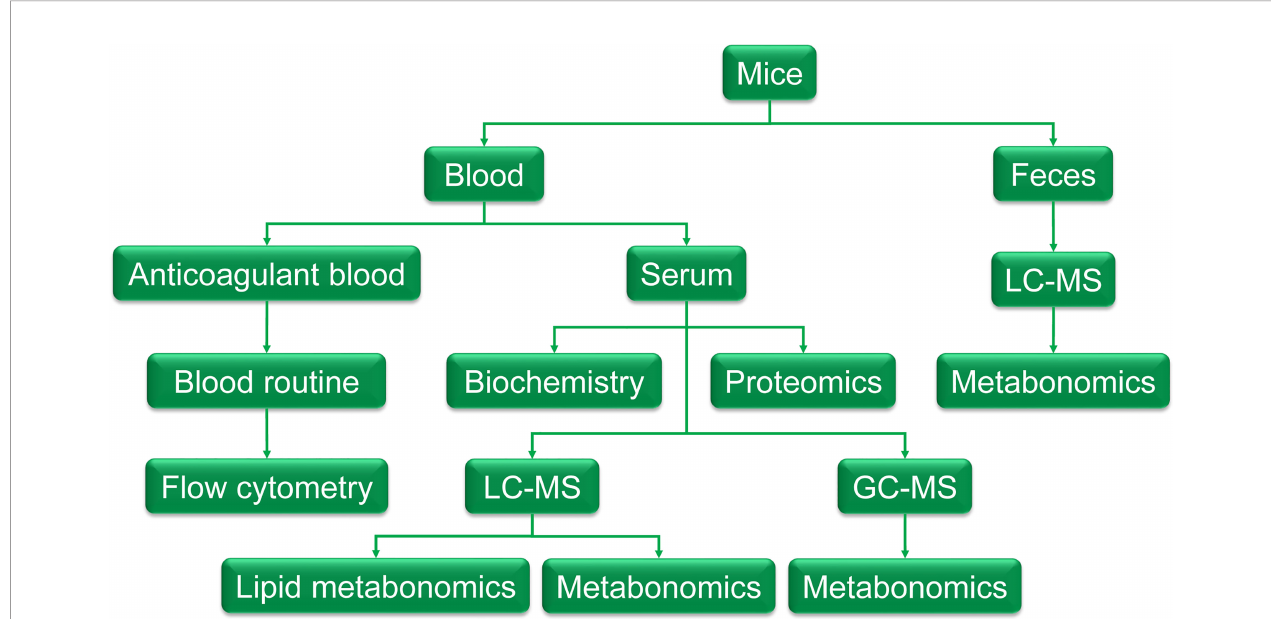
FIGURE 1 | The graphic of the methodology. Feces were collected the day before the end of the experiment and was cryopreserved at - 80°C for metabolomic examination. At the end of the experiment, fasting the night before dissection, blood was taken from the main abdominal vein after anesthesia with 60mg·kg -1 pentobarbital sodium. About 300ul of blood was injected into EDTA-K2 vacuum tubes to get anticoagulant blood for a routine blood test and fl ow cytometry, the remaining blood was injected into a gel separation tube and the serum was separated after centrifugation of 1000g. The serum was taken out for biochemistry detection, proteomics, and metabolomics